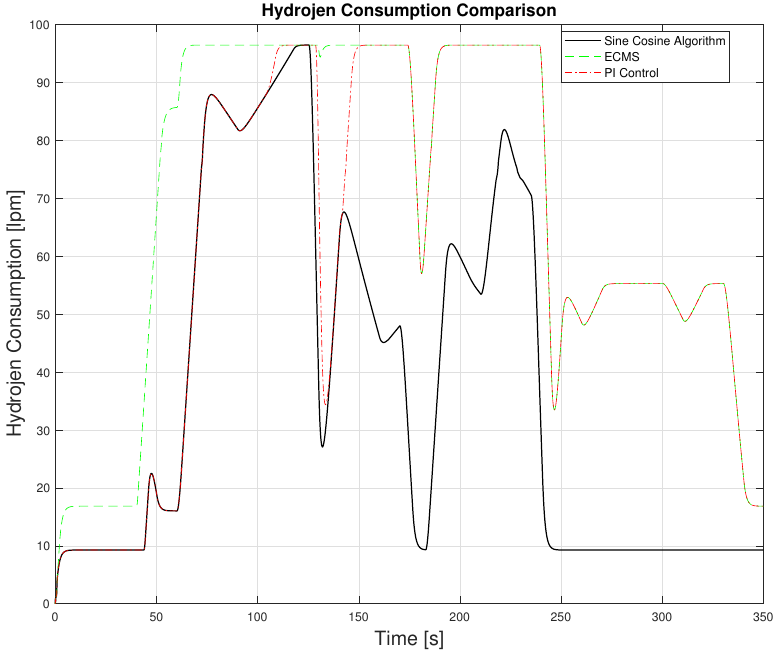
Figure 12. Change of hydrogen consumption for different algorithms during